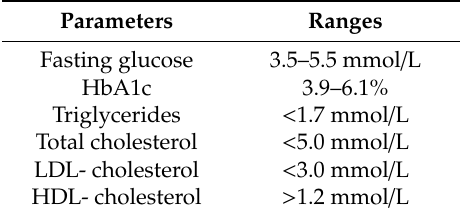
Table 1. Normal reference ranges for biomarkers of dyslipidemia [21].